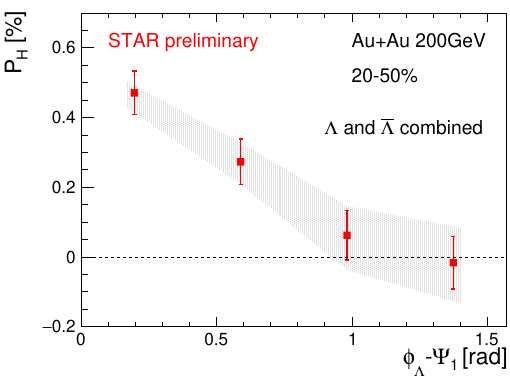
Figure 1: Global polarization of Λ+Λ as a function of azimuthal angle φ relative to the first- order event plane for 20-50% central Au + Au collisions at √ s NN = 200 GeV. The shaded band shows systematic